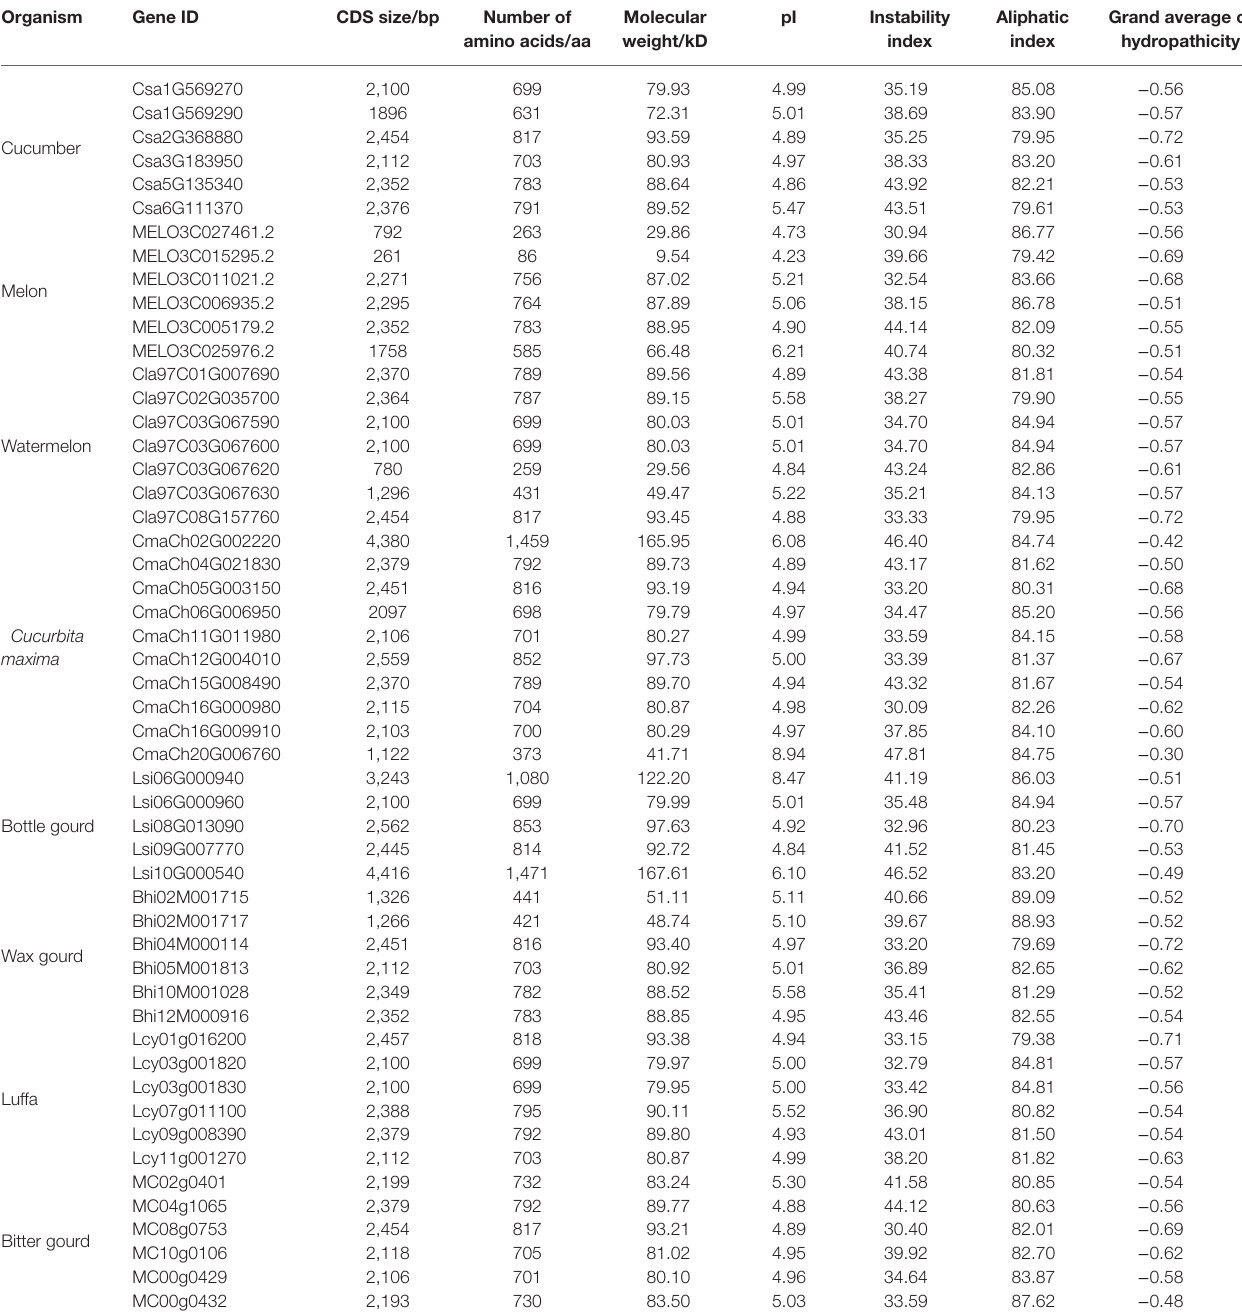
TABLE 1 | The physiochemical characteristics of HSP90 genes identified in the 8 Cucurbitaceae crops. Organism Gene